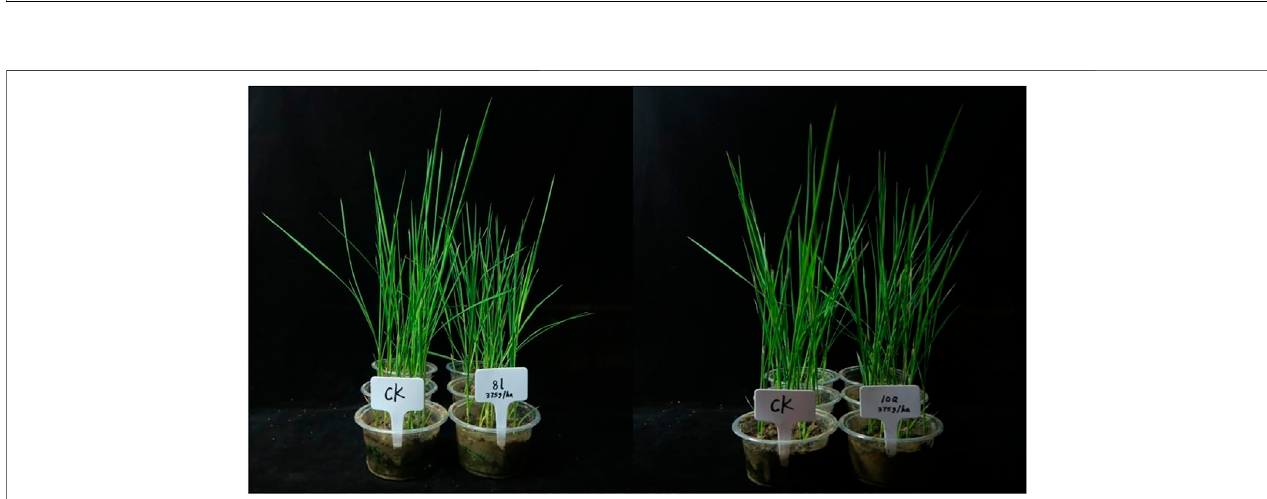
FIGURE 5 | Rice safety experiment in greenhouse-treated 375 g a.i./ha 8l and 10a after 14 days.